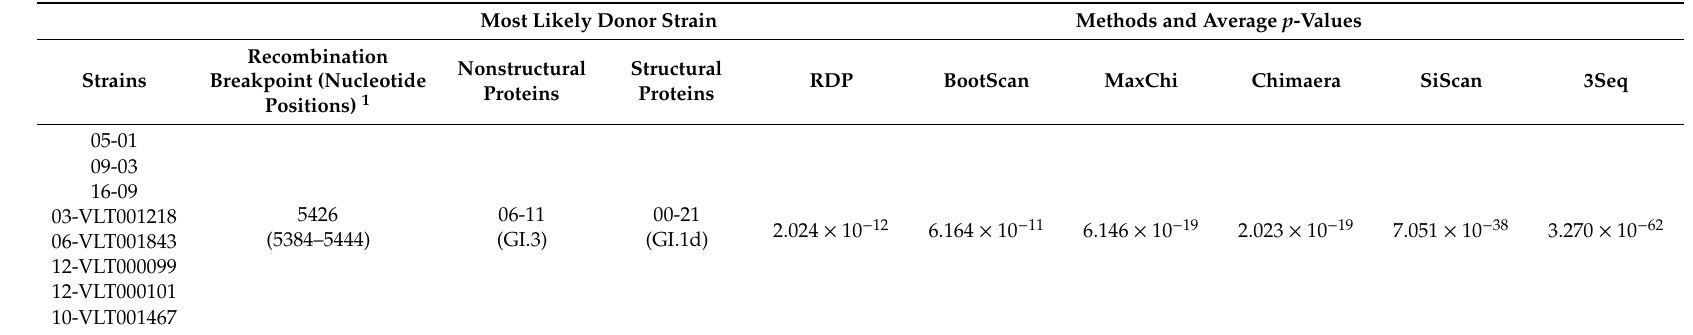
Table 2. Recombination results from the RDP software